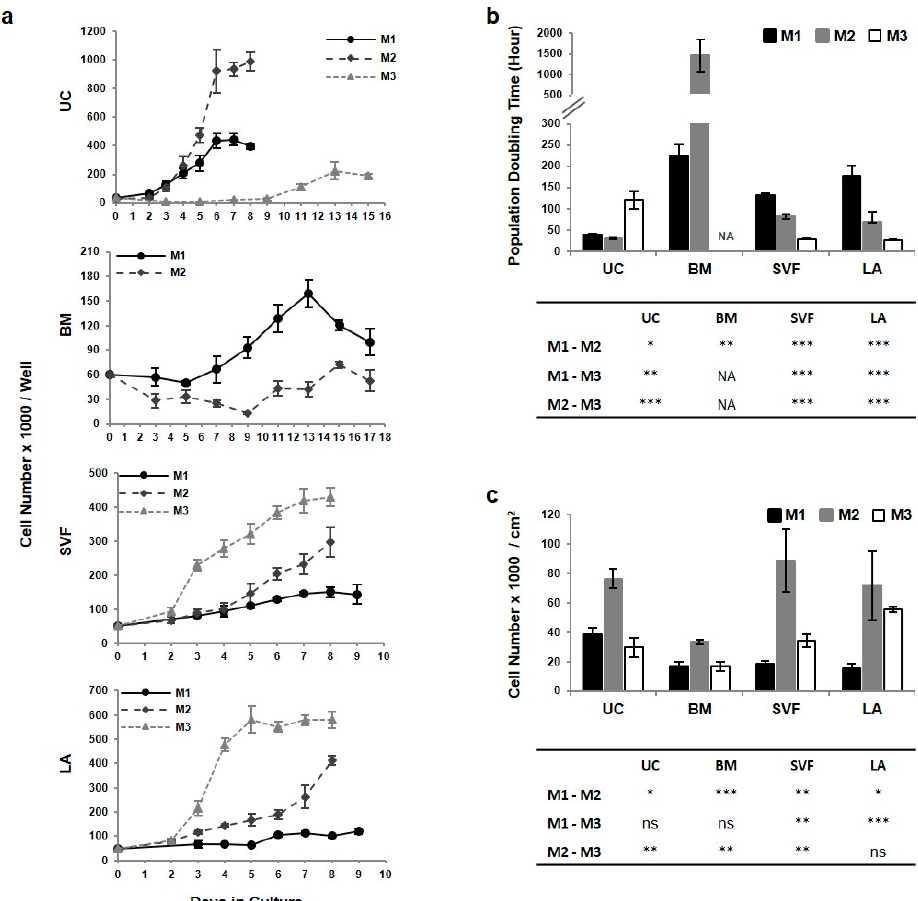
Figure 3. Growth characteristics of tissue-specific MSCs. During the third passage of tissue-specific MSCs in M1, M2 and M3 media, the growth curve was established ( a ) and population doubling time was calculated ( b ). ( c ) The yield of MSCs harvested at the 80–90% confluency. Results refer to the mean ± SD, n = 3. Tables in ( b , c ) show the significance level of difference between expansion media within MSC lines. Statistics: unpaired t test (* p < 0.05, ** p < 0.01, *** p < 0.001; ns, not significant). NA—not